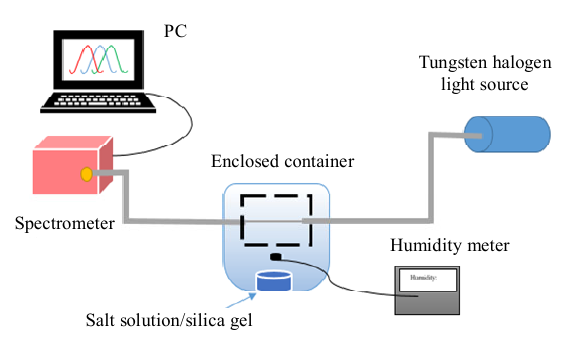
Fig. 3 Schematic diagram of the experimental